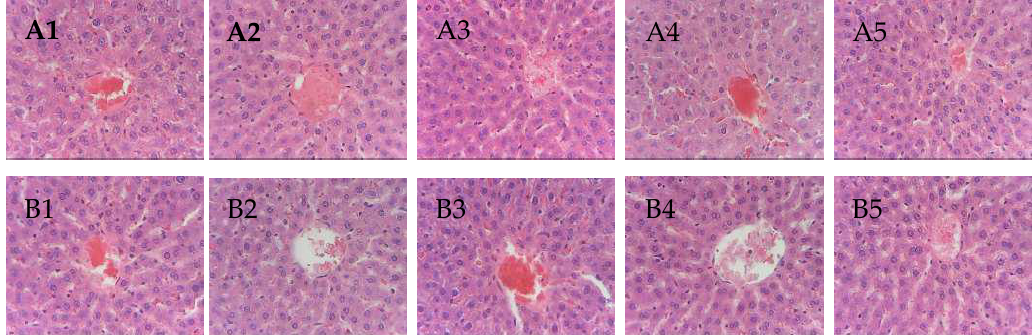
Figure 6. Micropictograph of the liver tissue sections for ( A ) magnolol treated group (from left to right, rat 1 to 5), and ( B ) mag@Uio-66(Zr)treated group (from left to right, rat 1 to 5). Samples were stained with hematoxylin and eosin dyes. Micropictograph was taken at the periacinar hepatocyte using 40X objective in an OlympusCH2 microscope fitted with a 5MP camera.